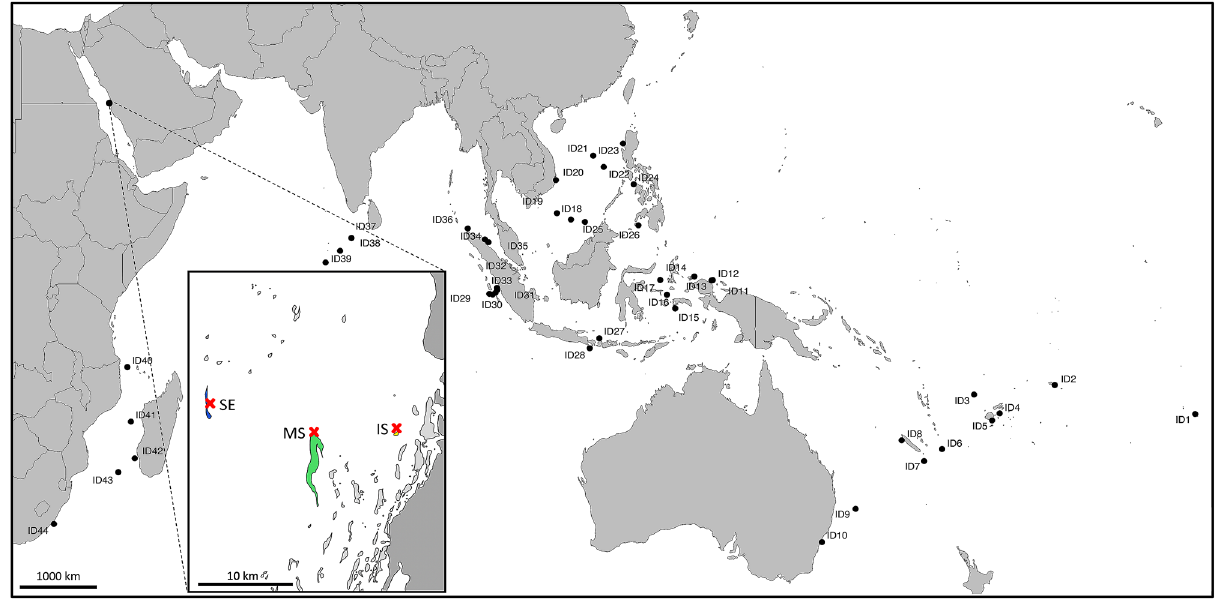
Figure 1. Collection sites of adult long dorsal fin (LDF) Schindleria: from the DANA Expedition 1928–1930 (all sites represented by a “dot”: ID1–ID44, following Ahnelt and Sauberer 12 ) and from the Red Sea (with a zoomed-in section displaying the three reefs where collection took place using a LED powered light trap along a cross-shelf gradient from the shore to the shelf edge, near the coast of Thuwal, Saudi Arabia). Coral reefs within the zoomed-in Red Sea section are given in “light grey” while the land sections are in “dark grey” and the sampled reef sites are color coded, with the “yellow” reef inshore (IS), the “green” reef at the mid-shelf (MS), and the “blue” reef at the shelf edge (SE). The “red” crosses indicate the location of deployment of the LED powered light traps for this study. The map was generated in R v. 4.0.2 (https:// www.r- proje ct. org) using the libraries